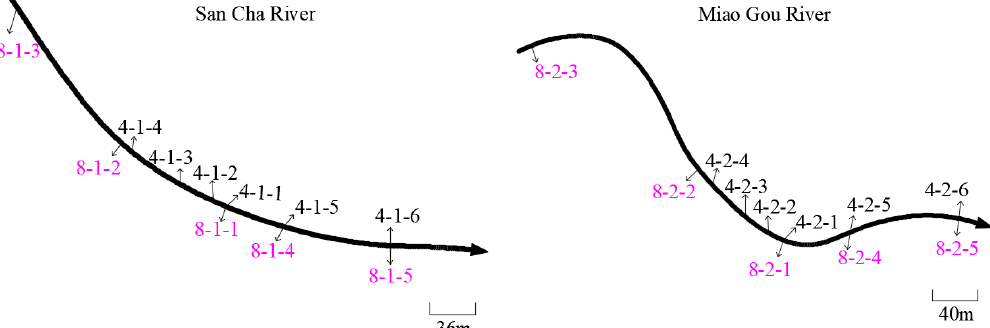
Figure 2. Schematic diagram of sampling sites within San Cha River and Miao Gou River (numbers in black represent the data of April collection, and the numbers in purple represent August collection; arrow indicates the direction of river).